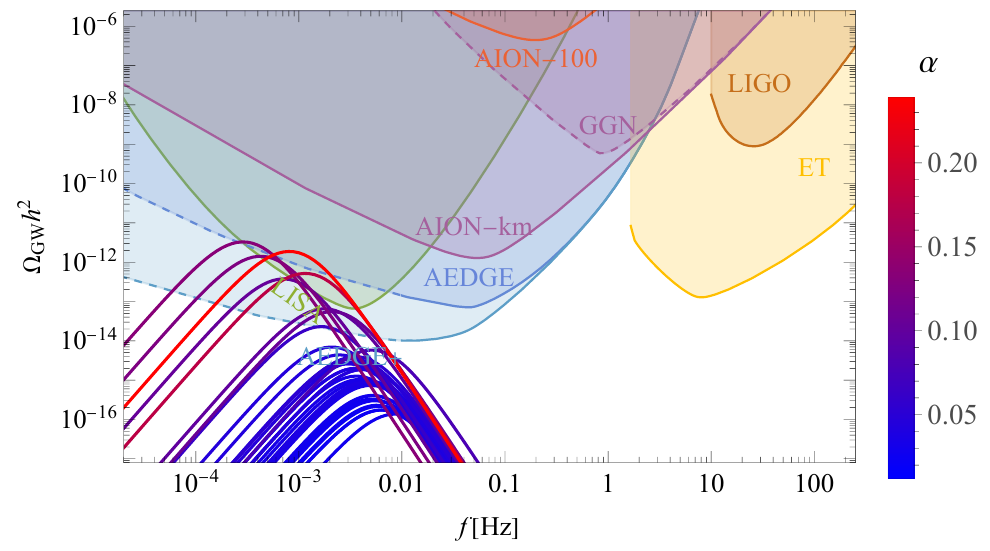
Figure 7 . Gravitational wave spectra from points in the parameter space for which the transitions are too strong and we do not find hydrodynamical solutions. Here we simply assume v w ≈ 1 . We note that these points are not suitable for